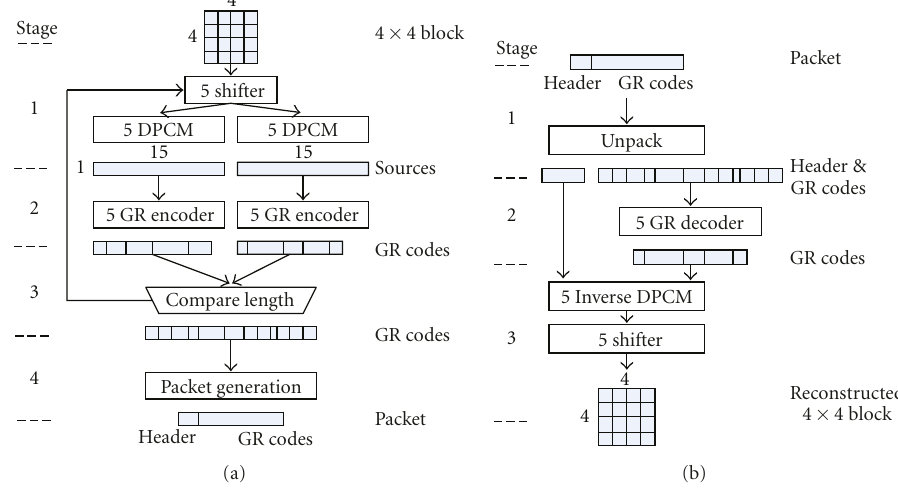
Figure 9: Block diagram of the FMC encoder and decoder.